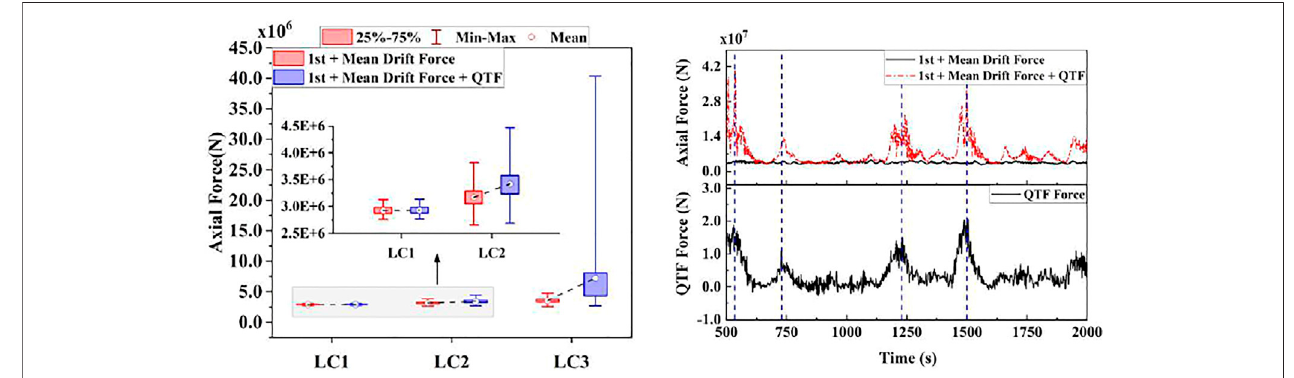
FIGURE 8 | Effect of the difference-frequency QTF on ML1 axial force response. (A) Statistical results. (B) Time-domain curves of the ML1 tension and QTF force.